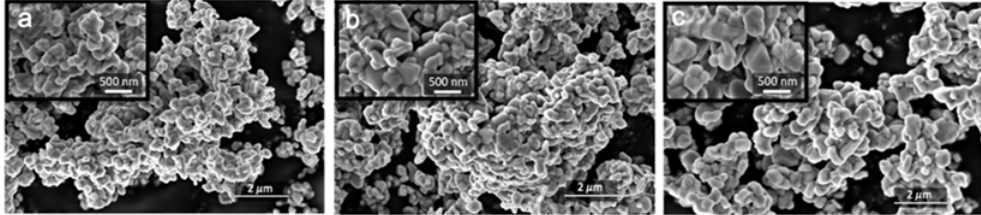
Figure 8. SEM images of the MW_15m_A ( a ), MW_30m_A ( b ) and MW_60m_A ( c ) NMC811 samples. Table 3. Discharge capacity and capacity retention for the MW and CP NMC811 samples.